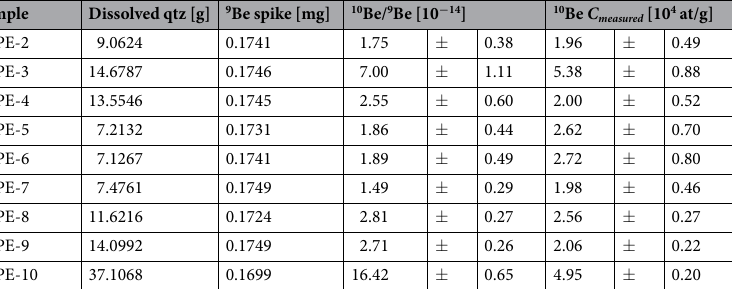
Table 1. Information on processed samples, measured 10 Be/ 9 Be ratios and 10 Be concentrations. The concentration of the used 9 Be spike is 1 g/l. Displayed quantities for C measured have been corrected for the long- term average 10 Be/ 9 Be blank ratio of 2.3 × 10 − 15 ± 0.1 × 10 − 15 measured for the clean laboratory where sample preparation took place (Institute of Geological Sciences, University of Bern).